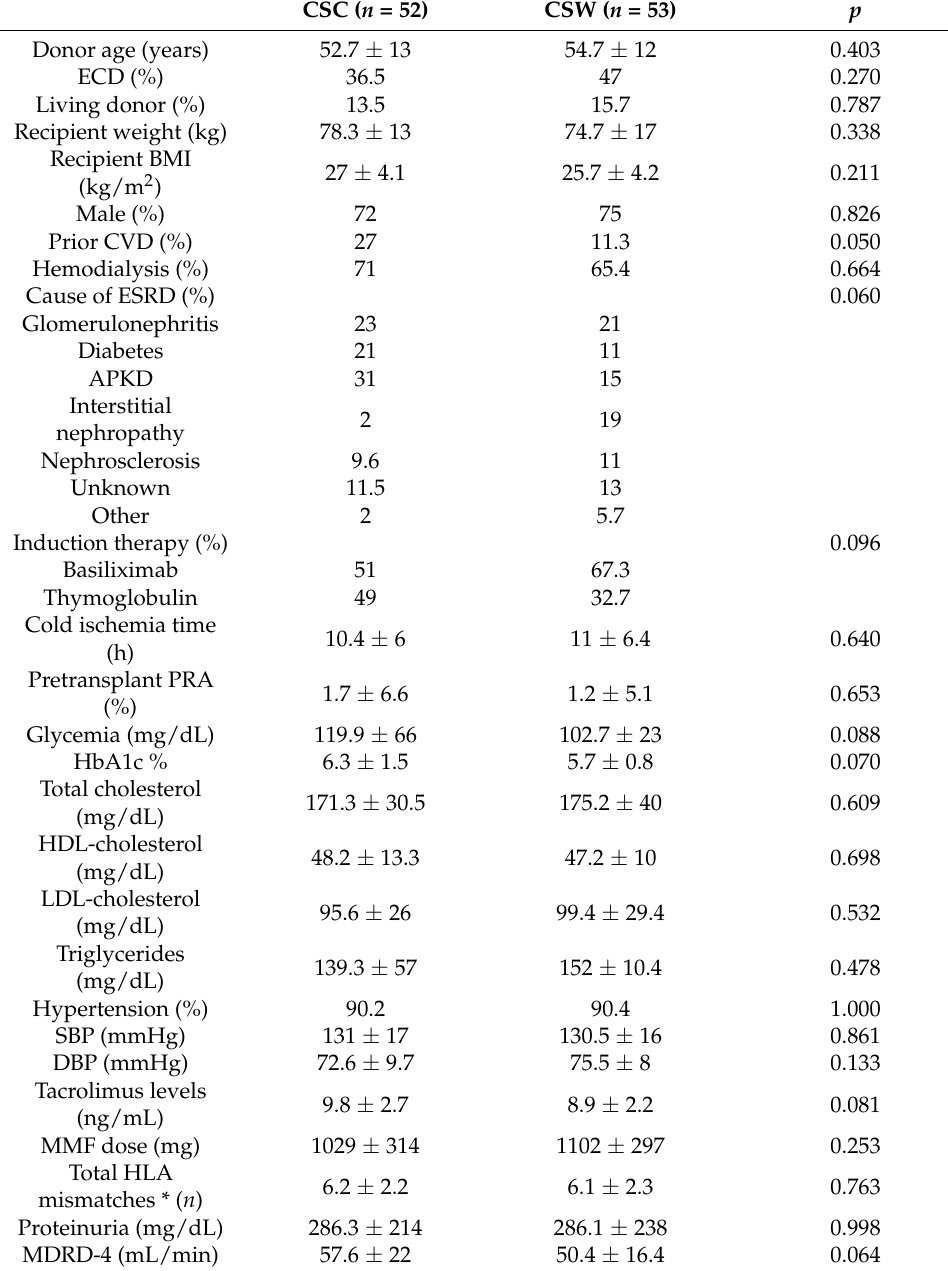
Table 1. Baseline clinical data at the time of randomization (3-months